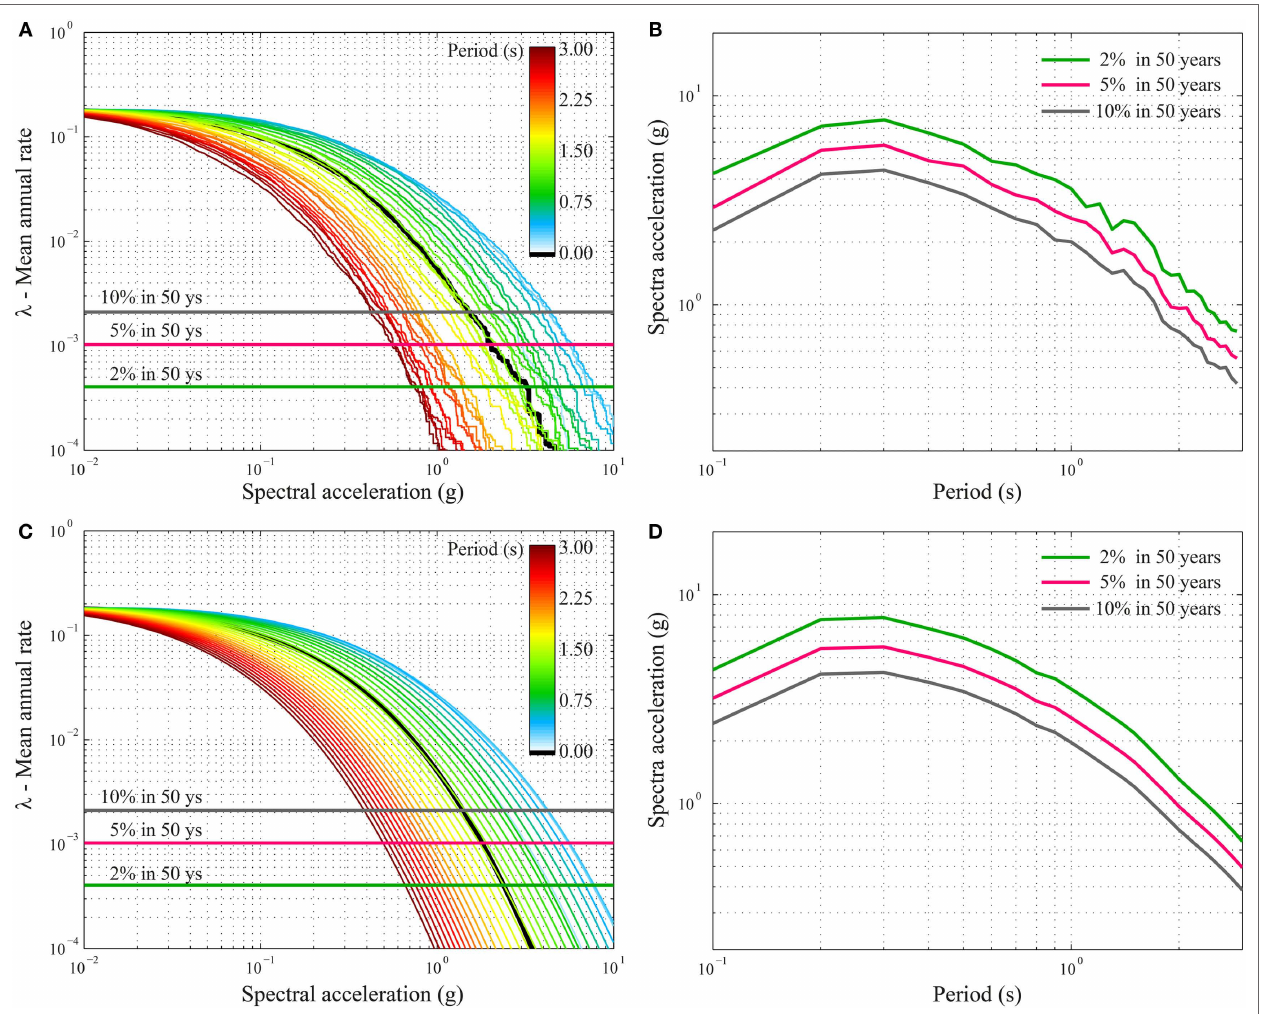
FIGURE 13 | (A) Final seismic hazard curves for intensity parameters from PGA (the black line) to S a ( T = 3s) based on 300 simulations. (B) Uniform hazard spectra based on 300 simulations. (C) Final seismic hazard curves for intensity parameters from PGA (the black line) to S a ( T = 3s) based on 300 (cid:2) 5000 simulations. (D) Uniform hazard spectra based on 300 (cid:2) 5000 simulations.